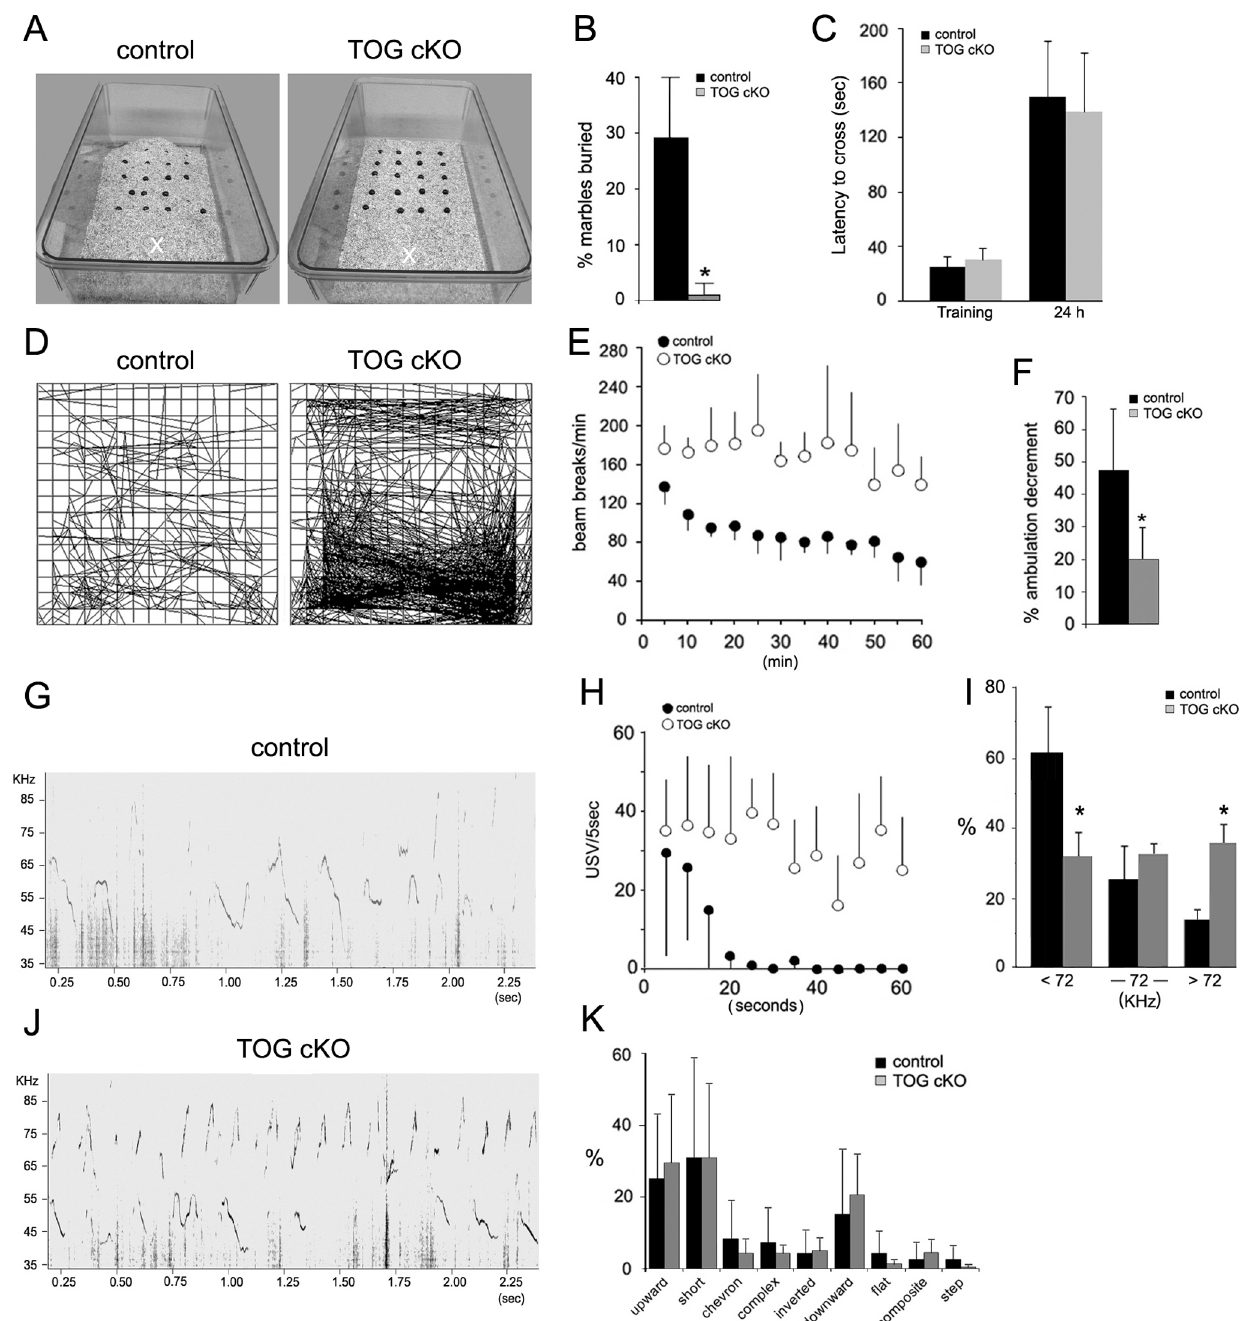
Figure 5. Behavioral phenotype of control and TOG cKO mice. A – B. Marble burying test. A. Marble distribution 30 minutes after a control (left) or a TOG cKO (right) mouse was placed in the cage at position indicated by X. B. Average numbers of marbles buried for both control and TOG cKO mice (n=10/genotype). Error bars indicate standard deviations (t-test; *p # 0.01). C. Passive avoidance test. Average latency to cross from the light chamber into the dark chamber for the training trial (Training) and retention trial (24 h) conducted 24 h after the training trial (n=10 mice/ genotype). Error bars indicate standard deviations (t-test; p . 0.05). D – F. Open field test. D. Representative ambulation patterns of control and TOG cKO mice. E. Average numbers of beam breaks per minute recorded at 5 minutes intervals are shown for 10 control and 7 TOG cKO males. Standard deviations for control and TOG cKO mice are indicated in opposite directions for clarity. F. Ambulation decrement: differences in ambulation scores in (E) between the first 15 minutes and the last 15 minutes of the observation period calculated as percentage of the first 15 minutes of observation; (t- test; *p # 0.05). G – K. USV recording for control and TOG cKO animals. Representative USVs patterns for control (G) and TOG cKO (J) mice. H. Average numbers of USVs recorded per 5 sec at 5 sec intervals are shown for control (n=5) and TOG cKO (n=5) males (ANOVA, F=11.7; df=1,110; p=0.009). Standard deviations for control and TOG cKO mice are indicated in opposite directions for clarity. I. USV frequencies for control and TOG cKO mice. Percent of USVs below 72 KHz, spanning the 72 KHz arbitrary boundary, and above 72 KHz during 1 min of recording. K. USVs categories for control and TOG cKO mice.